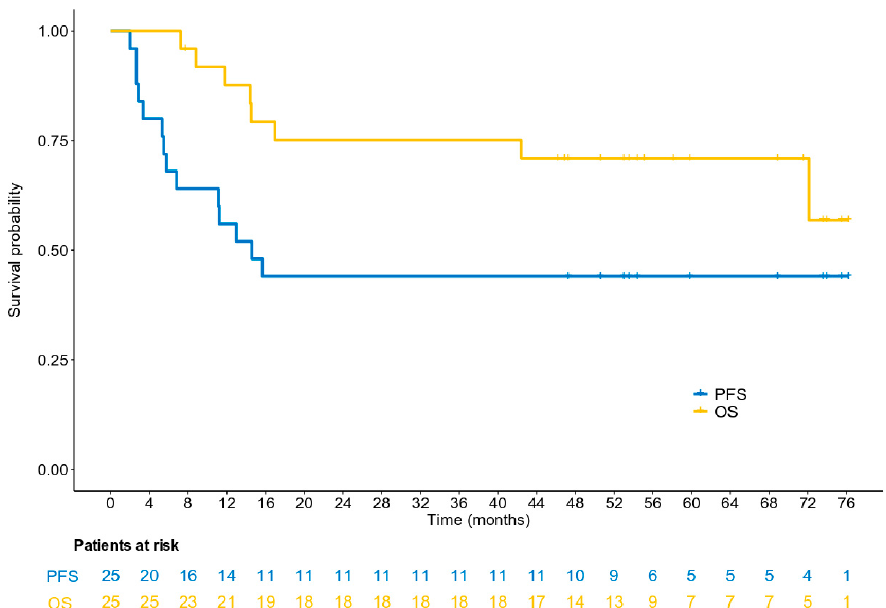
Figure 4. A Kaplan-Meier plot with respect to progression-free survival (PFS) and overall survival (OS).